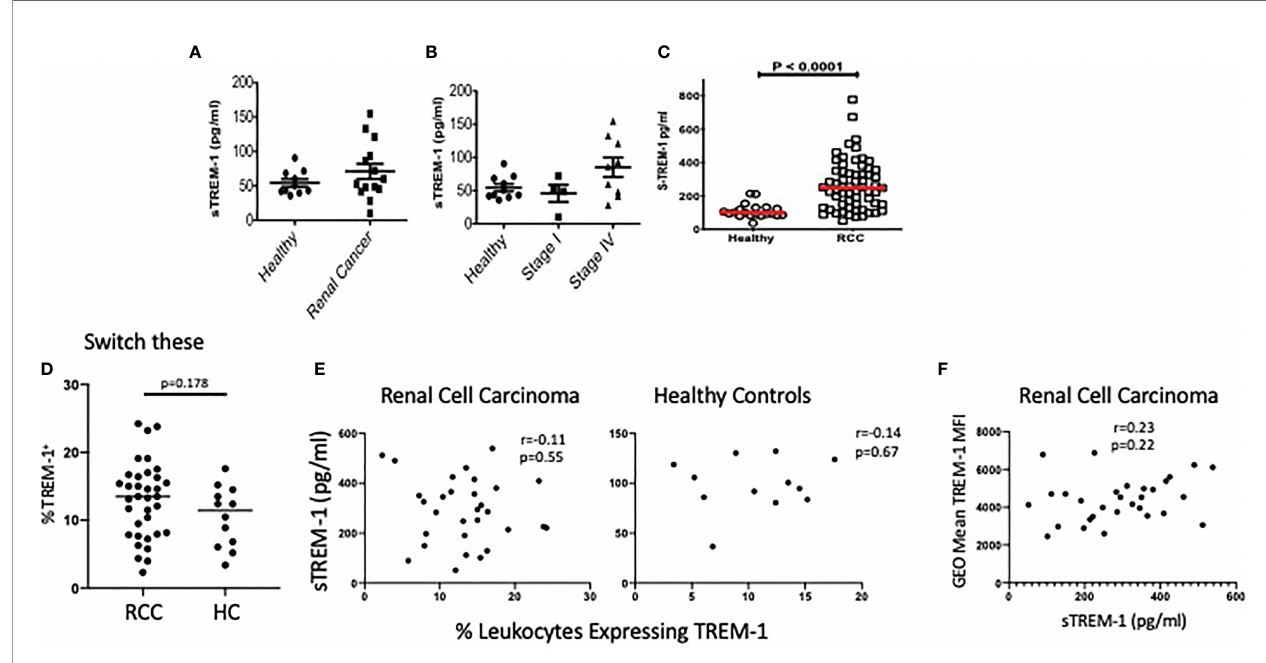
FIGURE 7 | sTREM-1 levels are increased in the plasma of patients with renal cell carcinoma. (A) Serum from healthy donors ( n = 10) or patients with either localized ( n = 5) or metastatic ( n = 9) renal cell carcinoma (RCC) was tested for soluble TREM-1 (sTREM-1) levels by ELISA. (B) sTREM-1 levels between stage I (localized) and stage IV (metastatic) RCC patients demonstrating a trend towards higher levels with worsening stage. (C) sTREM-1 levels in RCC patients from the Fox Chase Cancer Center ( n = 63) and healthy controls ( n = 20). (D) Percent of CD45+ blood leukocytes expressing TREM-1 in RCC patients and healthy controls. (E) Soluble TREM-1 levels are plotted vs . the percentages of blood leukocytes expressing TREM-1 in RCC (left) and healthy controls (right). The r values and p - values of the correlation analysis are shown. (F) Fluorescence intensity (geometric mean) of TREM-1 staining of RCC patients is plotted against the sTREM-1 values for those same patients. The r values and p -values of the correlation analysis are